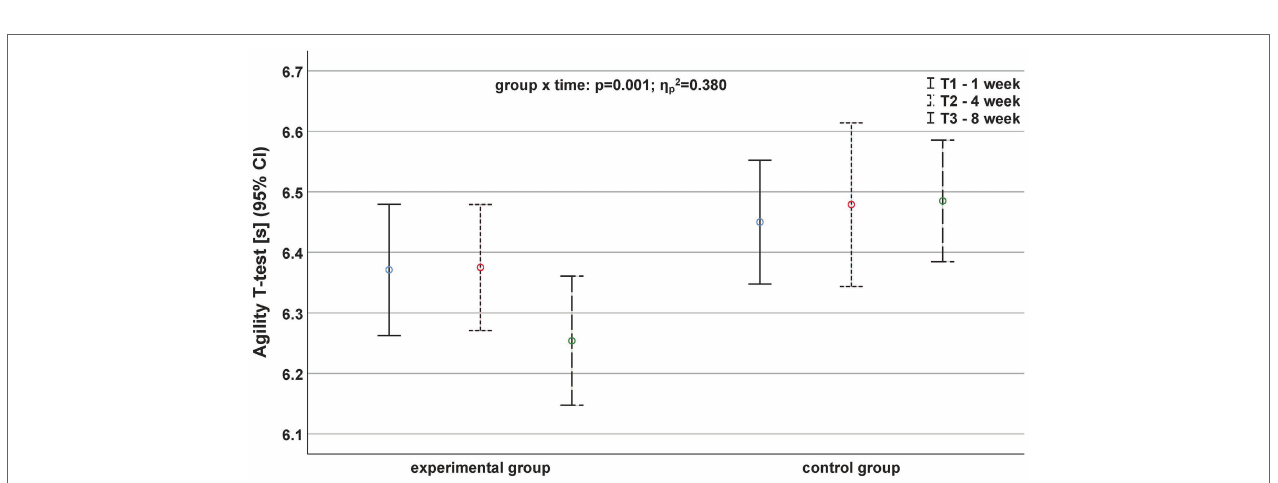
FIGURE 3 | Development of agility performance based on the parameter agility T -test before (continuous black line), after 4 weeks (fine dashed black line), and after (roughly dashed black line) the exercise program depending on the